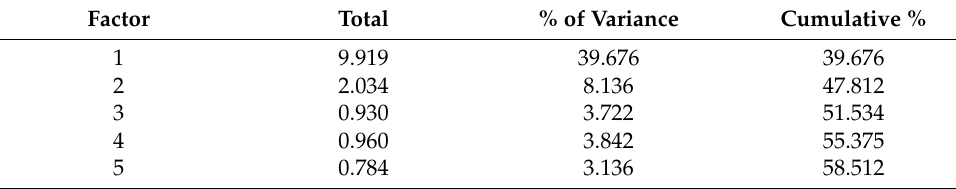
Figure 2. Scree plot with a horizontal line at eigenvalue = 1.0. Table 5. Sums of load squares after isolation (analysis without one factor option enforced).